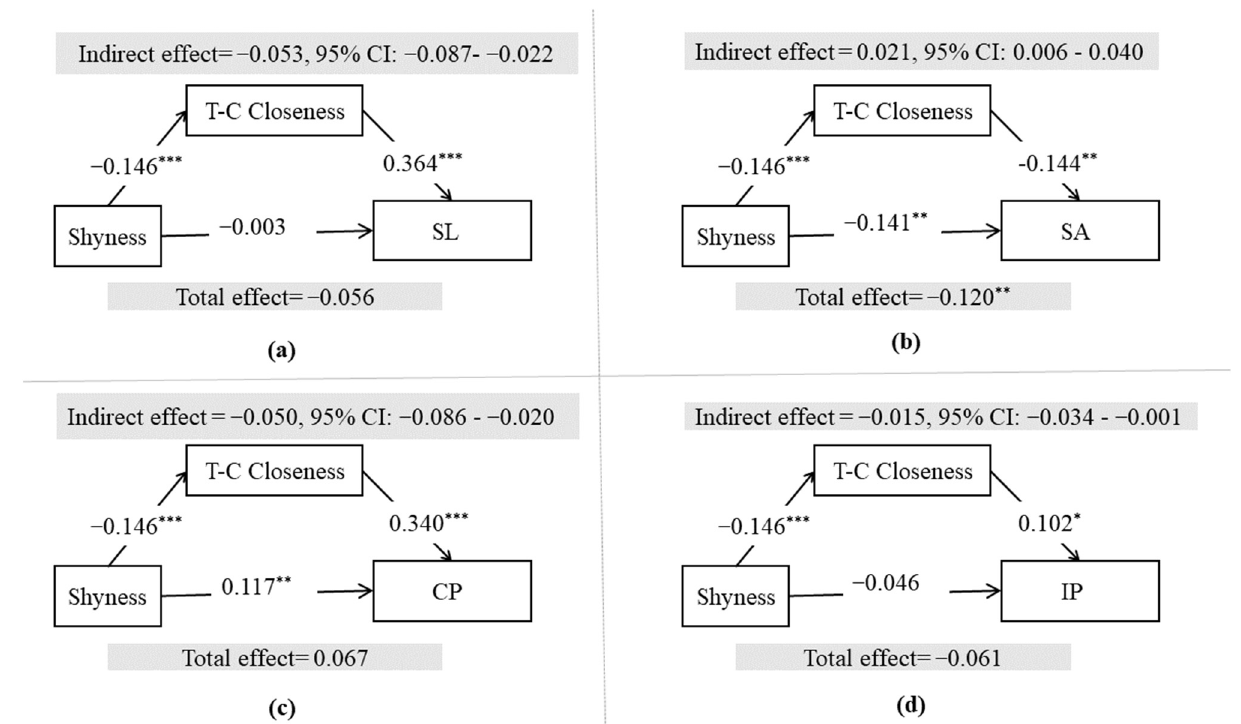
Figure 1. Mediation models with path coefficients. Note. The effects of grade was controlled. T-C = teacher–child, SL = school liking, SA = school avoidance, CP = cooperative participation, IP = inde- pendent participation. * p < 0.05; ** p < 0.01; *** p < 0.001. ( a ) Mediation model for school liking; ( b